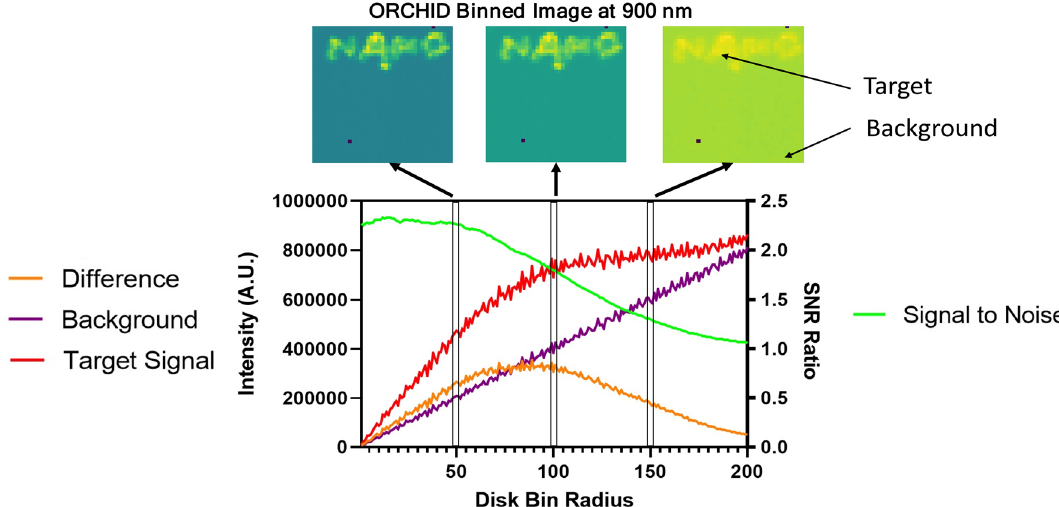
Figure 7. Plotted comparisons of target signal pixel (inside the “NANO”) and a background pixel as a function of disk binning radius (of 1 pixel width) used to form the raw images. Three resultant images are produced at 50, 100, and 150 disk bin radii each showing a changing contrast in each image. With increasing bin radius, the target signal difference from background is greatest between 50 and 100 pixel disk bin radius. This results in the greatest contrast in the middle resultant binned image shown